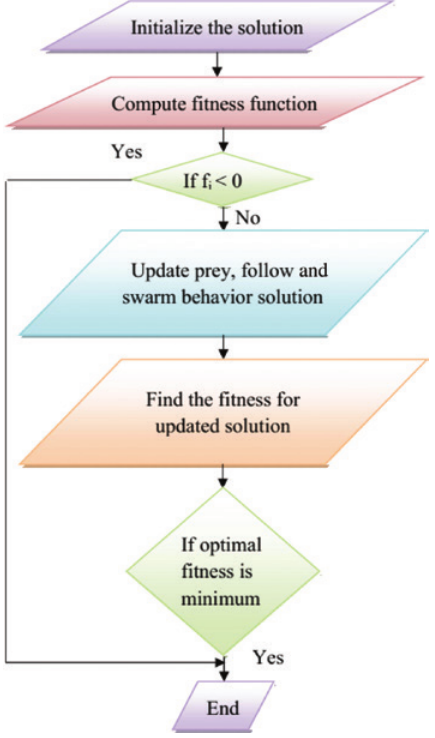
Figure 3: Flowchart for Particle Swarm Optimization